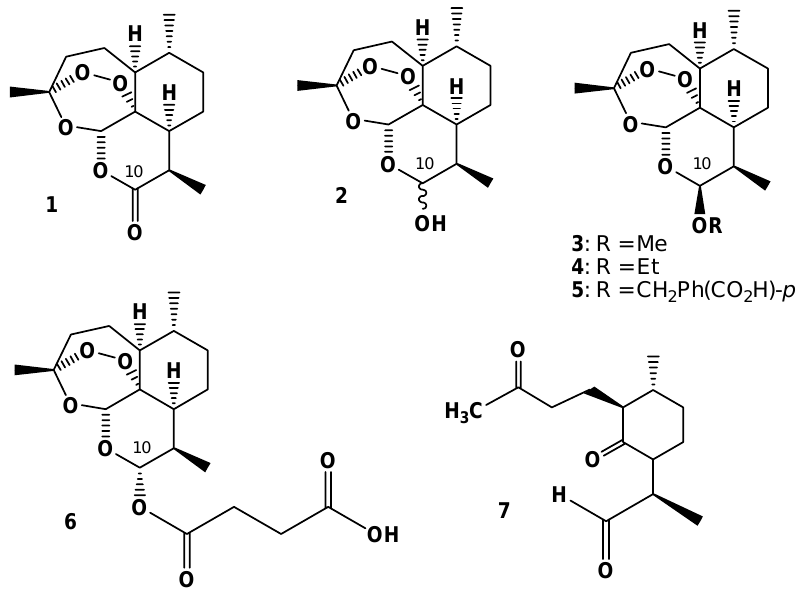
Figure 1. Chemical structures of artemisinin ( 1 ), dihydroartemisinin (DHA, 2 ), artemether ( 3 ), arteether ( 4 ), artelinic acid ( 5 ), artesunic acid ( 6 ), and a ubiquitous thermal decomposition product of 2 designated as diketoaldehyde (DKA, 7